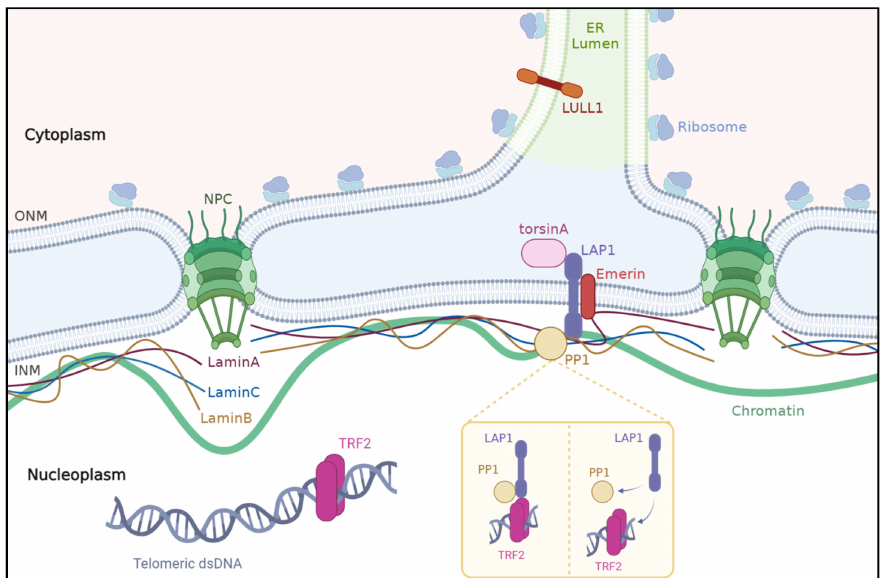
Figure 2. Schematic of LAP1’s main interactions. The nuclear envelope formed by the outer and inner membranes (ONM and INM, respectively). The latter is underlaid by a network of type V intermediate filaments (A/C- and B-type lamins) forming the basal lamina. ONM is in direct contact with the endoplasmic reticulum. NE contains transport channels called nuclear pore complexes. LAP1 is located on the INM and interacts with emerin and lamins, either directly or via emerin, contributing to maintaining skeletal muscle and NE structure integrity. Activation of TorsinA ATPase activity requires interaction with LAP1 at the NE or LULL1 at the ER. PP1 mediates LAP1’s Ser306 and Ser310 residues dephosphorylation. In response to DNA damage, phosphorylated LAP1 interacts with TRF2 that is part of the shelterin complex, a structure ensuring telomer repair and genome integrity. ER: endoplasmic reticulum; INM: inner nuclear membrane; LAP1: lamina-associated protein 1; LULL1: luminal domain-like LAP1; NE: nuclear envelope; NPC: nuclear pore complex; ONM: outer nuclear membrane; PP1: protein phosphatase